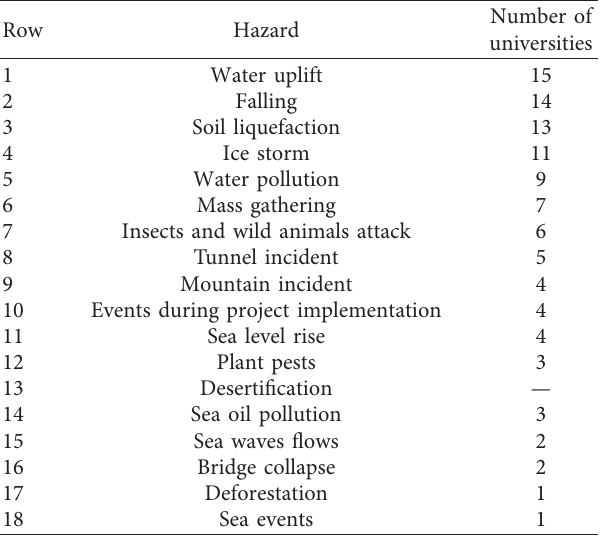
Figure 1: The top 20 health-oriented hazards in Iran based on data from years Table 6: The hazards that were explored for the first time in the medical universities area in Iran.